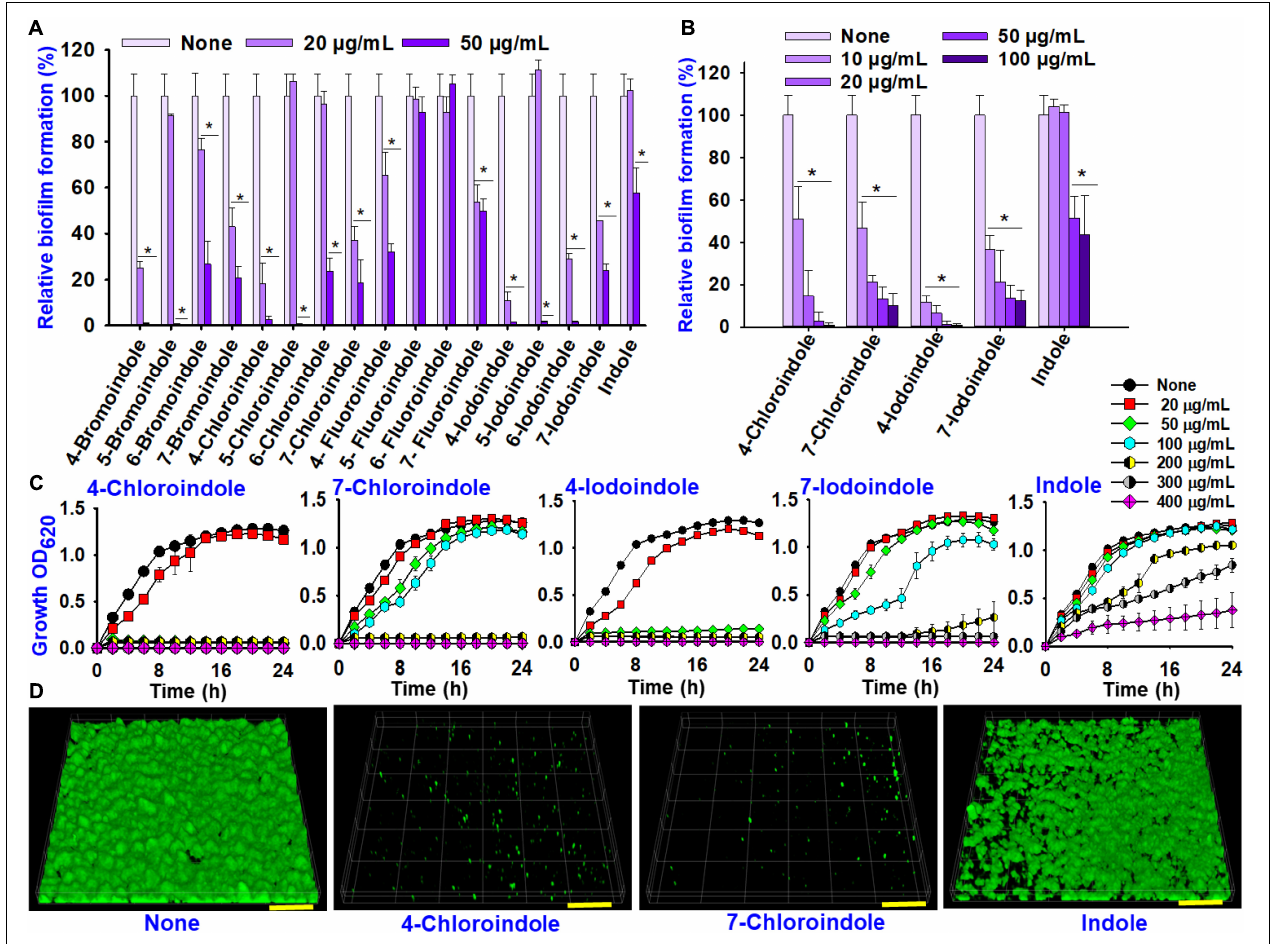
FIGURE 1 | Effects of indole and halogenated indoles on biofilm formation and planktonic cell growth against V. parahaemolyticus . The antibiofilm activity of halogenated indoles (A) . Antibiofilm activity of four selected halogenated indoles and indole (B) . Growth curve of V. parahaemolyticus treated with different concentration of the four selected halogenated indoles and indole (C) . CLSM images of V. parahaemolyticus biofilms with or without 50 µ g/mL of 4-chloroindole, 7-chloroindole, and indole (D) . The scale bar is 100 µ m. Asterisks (*) represent significant differences ( p <